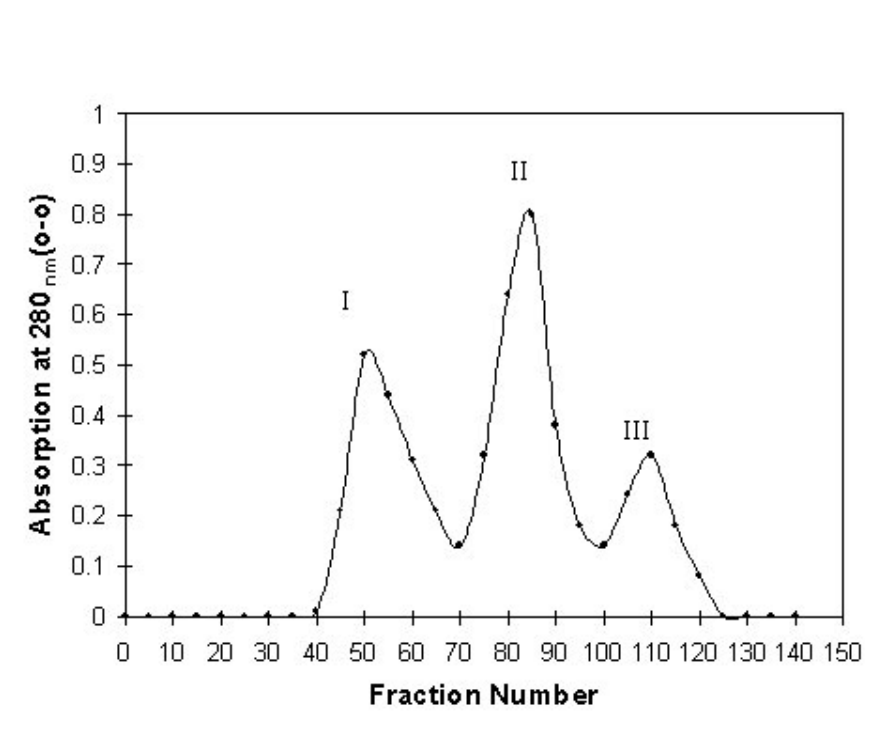
Figure 2: Gel filtration chromatography of Peak-III from Figure 3 (Lane D) on a Sephadex G-50 column (1.5 x 60 cm). Fractions were eluted with 0.01 M Tris-HCl, pH 8.5, at a flow rate of 12 ml/h, and those fractions of 3.0 ml were